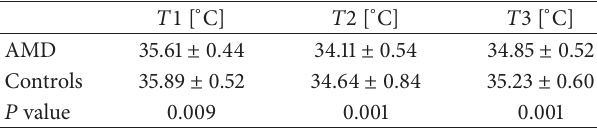
Figure 2: Average OST profiles of AMD patients and controls. Table 2: Ocular surface temperature of all three points expressed as means ± one standard deviation for all AMD patients and